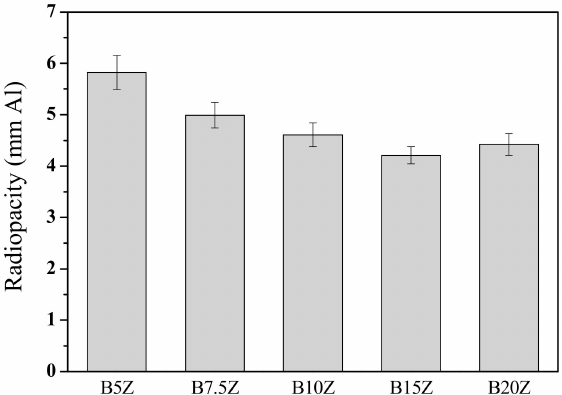
Figure 5. Radiopacity performance of MTA-like cements prepared by various 30 min as-milled zirconia-added bismuth oxide powder into which B5Z, B7.5Z, B10Z, B15Z, and B20Z, indicating 5, 7.5%, 10%, 15%, and 20% zirconia, was added